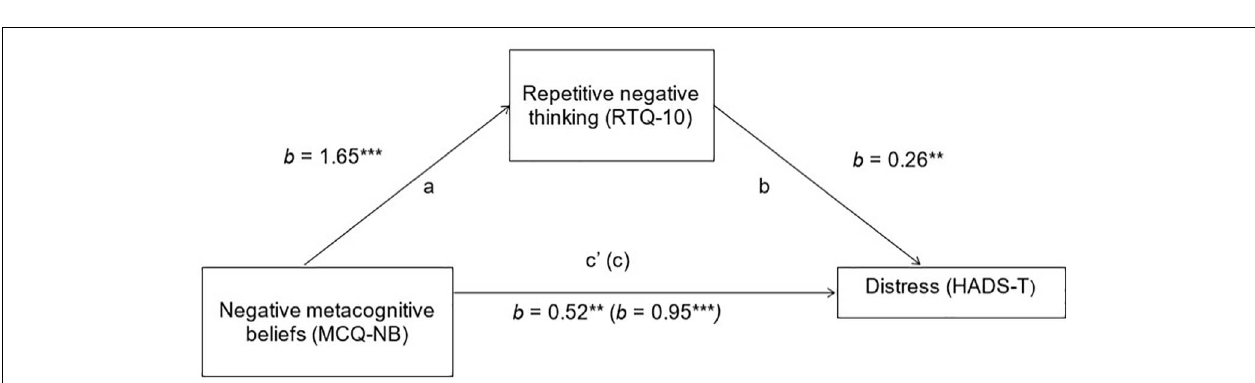
FIGURE 2 | Mediation of positive met a cognitive beliefs on emotional distress, via Repetitive Negative Thinking. HADS-T, total adapted Hospital Anxiety and Depression Scale score; MCQ-PB, Metacognitions Questionnaire-30 positive beliefs about worry subscale; RTQ-10, Repetitive Thinking Questionnaire; ns, non-significant. *p < 0.05 : **p < 0.01, and ***p < 0.001.